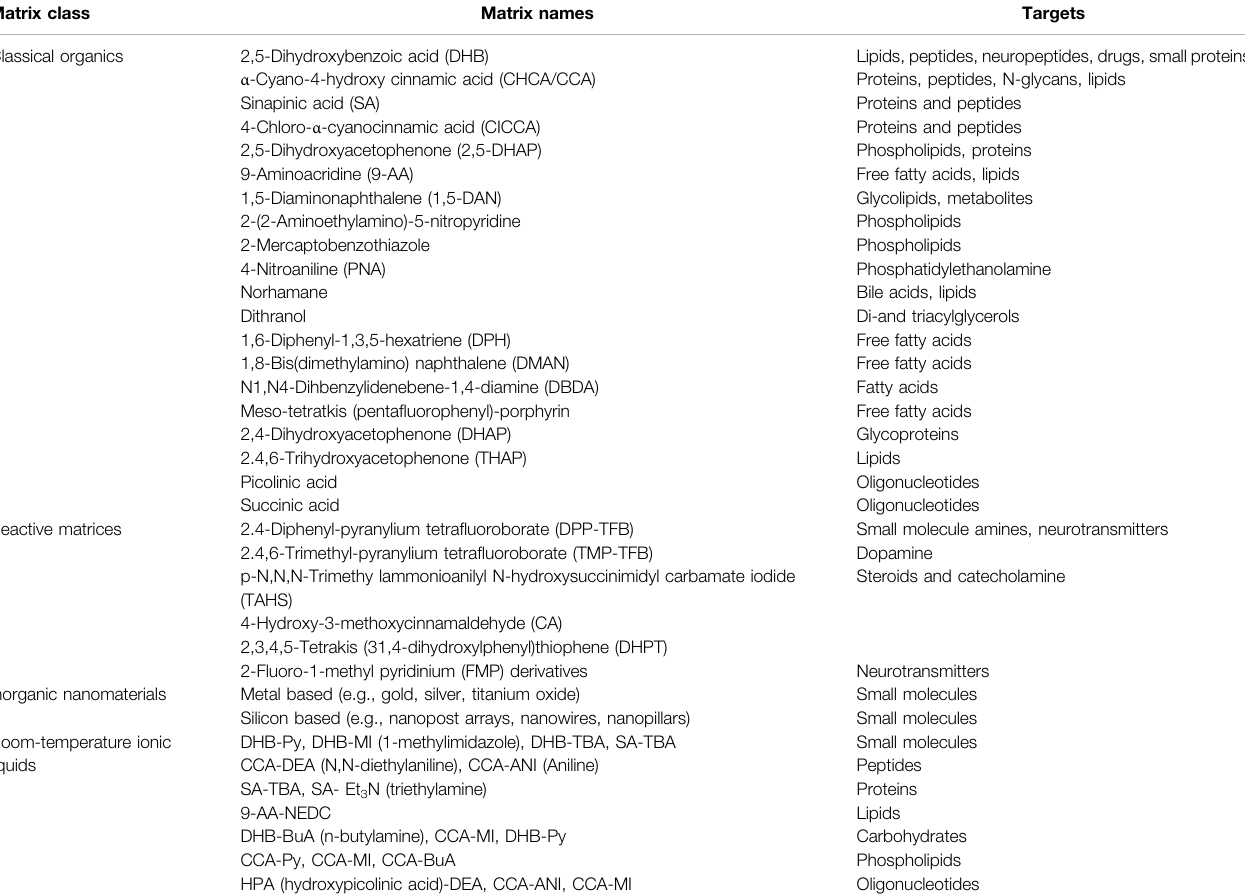
TABLE 2 | Common matrices used for MALDI MSI targets (Tholey and Heinzle, 2006; Tobias and Hummon, 2020; Schnackenberg et al., 2021). Matrix